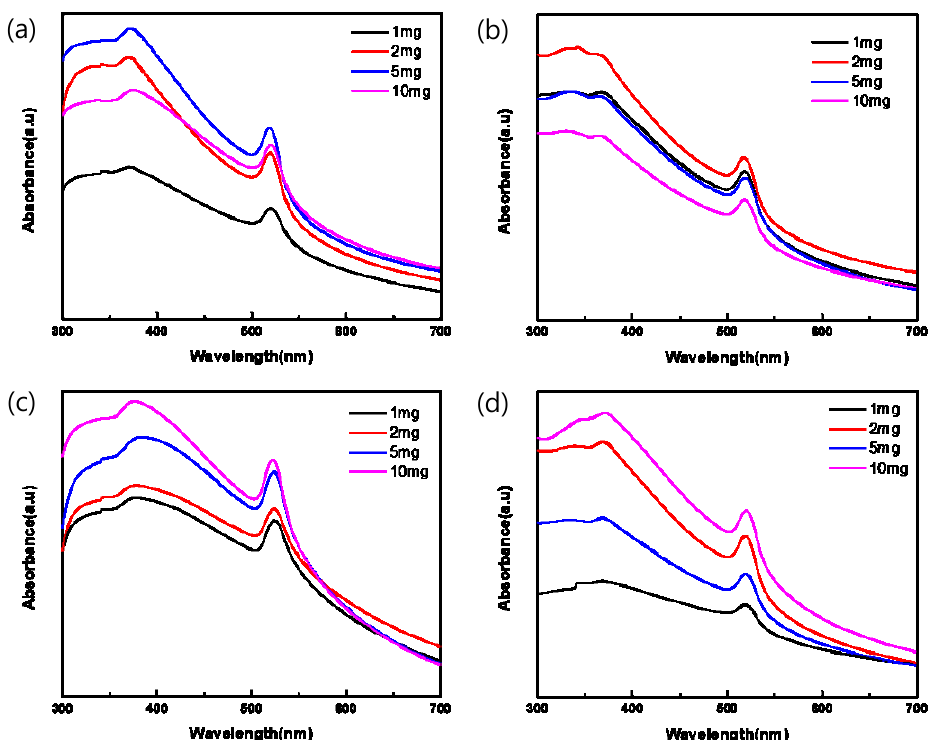
Figure 3. Absorption spectra of pa-ZnO-doped CsPbBr 3 perovskite films with various amounts of pa-ZnO nanopowder dopants with treatment of annealing temperatures at ( a ) 200 °C, ( b ) 300 °C, ( c ) 400 °C, and ( d ) 500 °C.